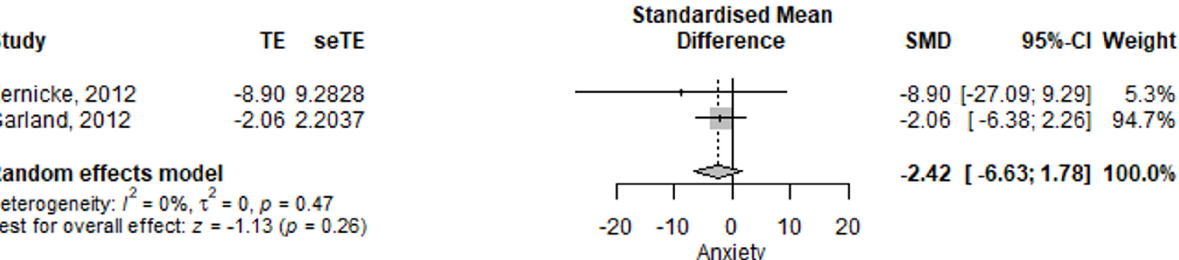
effect as SMD; seTE, standard error of the treatment effect; CI, confidence interval [15,17]. SMD; seTE, standard error of the treatment effect; CI, confidence interval